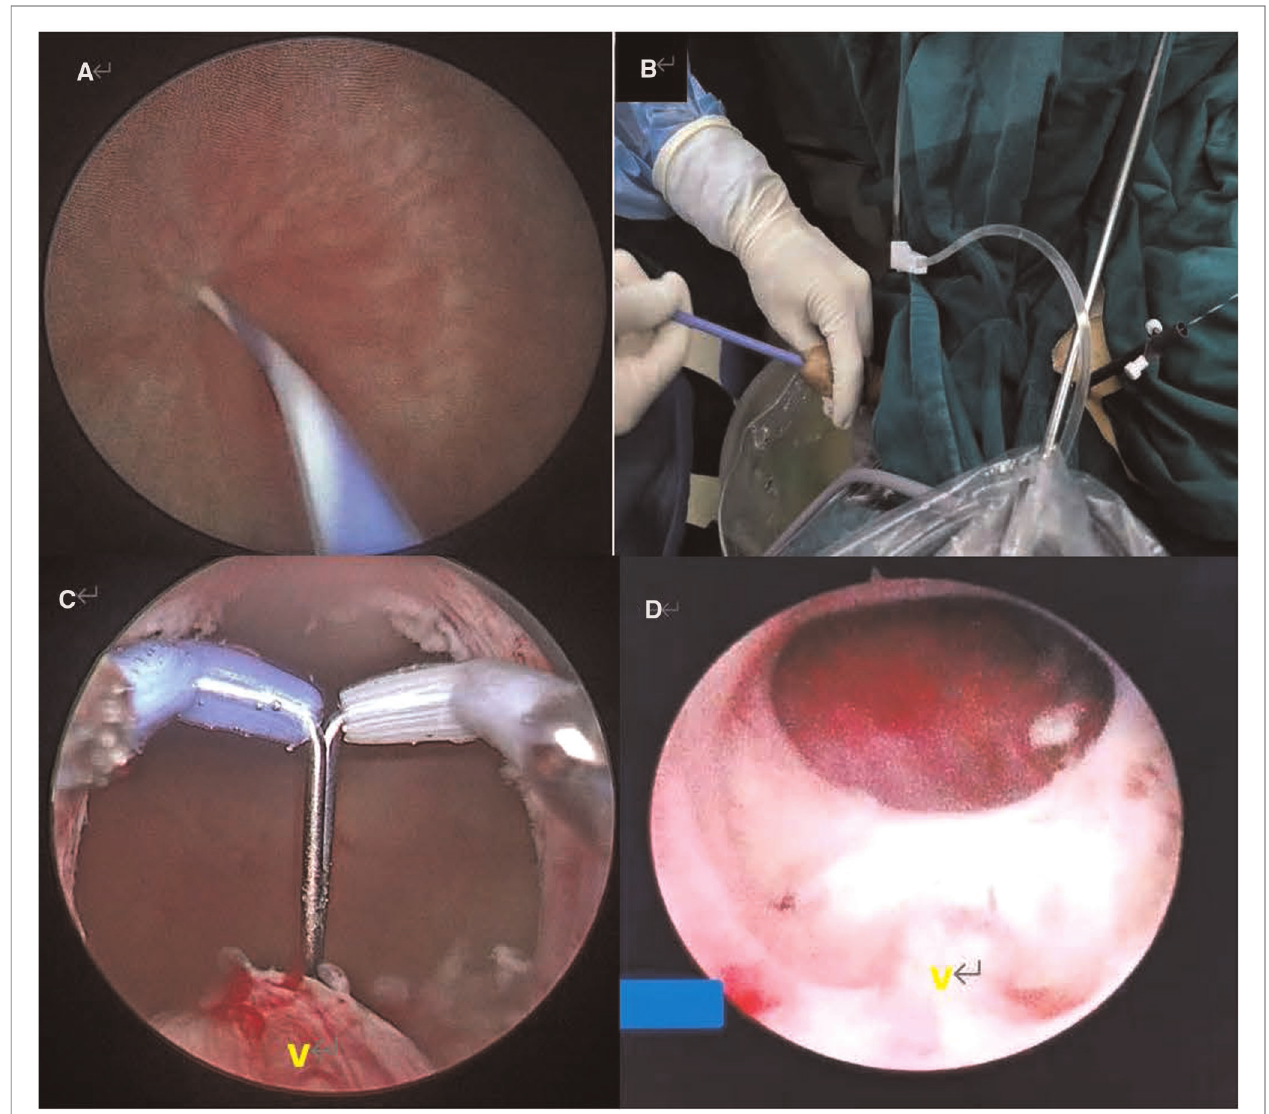
FIGURE 1 | ( A ) Introperative ureteroscopic view of a pinpoint-like bladder neck; ( B ) suprapubic cystostomy and dilation of the bladder neck; ( C ) immediate resectoscopic view of a bladder neck after TUIBN; ( D ) cystoscopic view of a bladder neck 18 months after